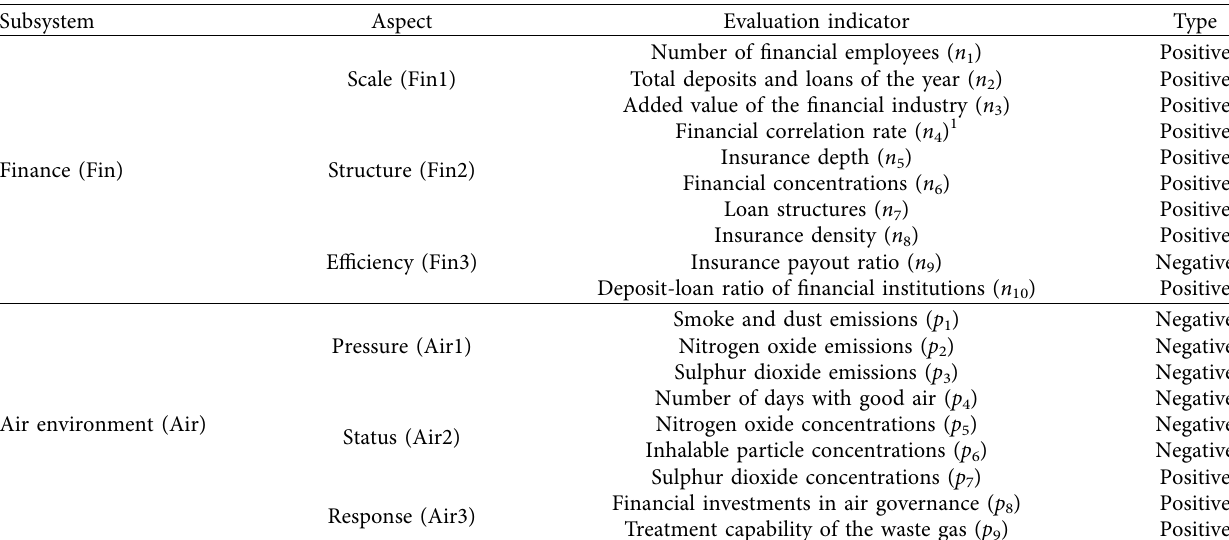
Figure 1: Coupling coordination mechanism. Table 1: Evaluation index.